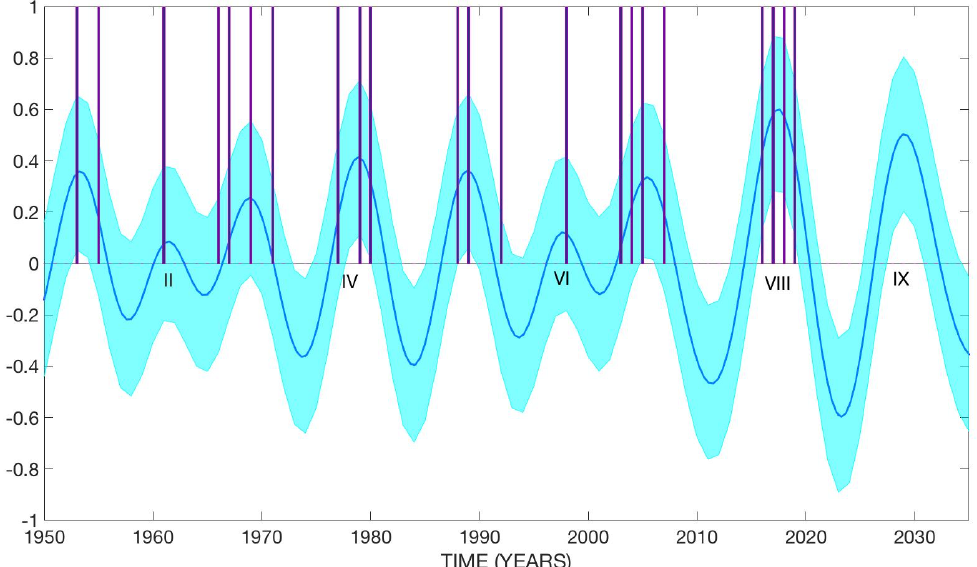
Figure 2. Probabilistic hindcasts and forecasts for the category 5 Atlantic hurricanes. Bayesian inference of the LS-SVM model (blue line and shade) compared with the historical category 5 Atlantic hurricanes (purple vertical bars) clustered in 8 groups (I–VIII). In addition, the probabilistic prediction of category 5 Atlantic hurricane is shown for the following period (cluster IX). The blue shaded area represents the 95% confidence intervals of the Bayesian